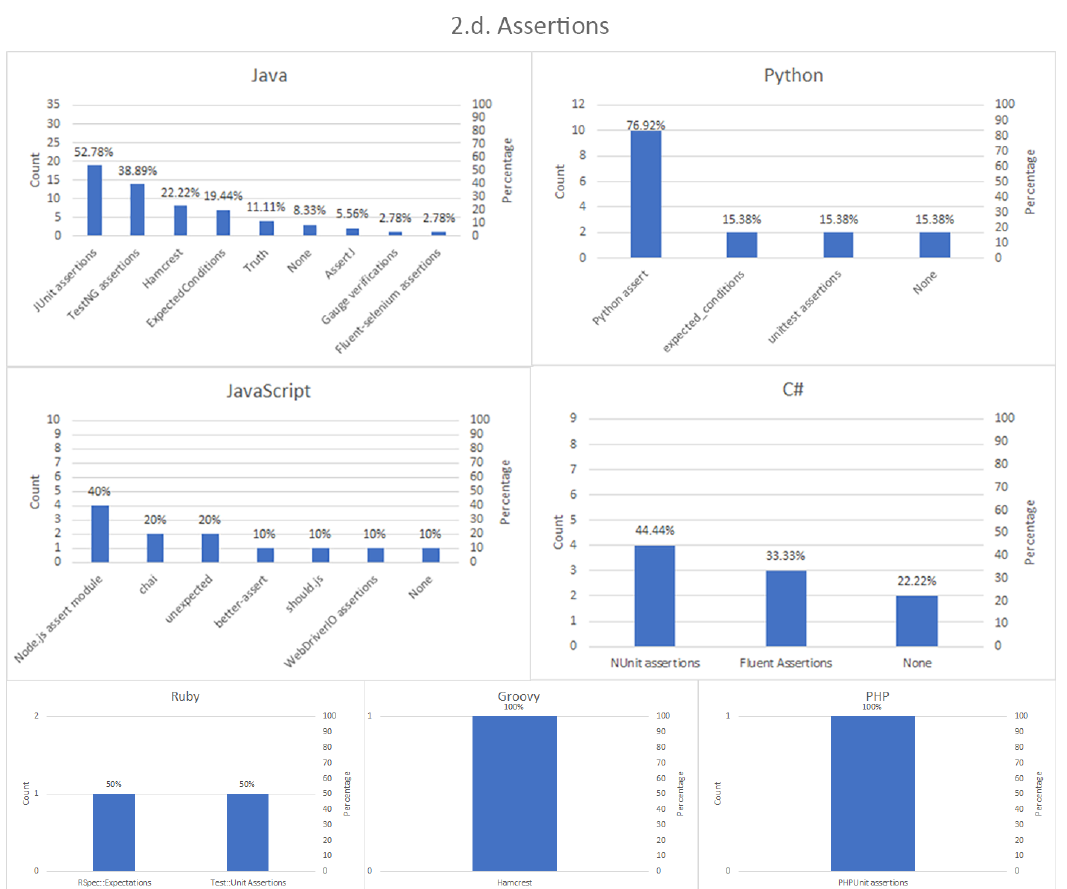
Figure 8. Assertion